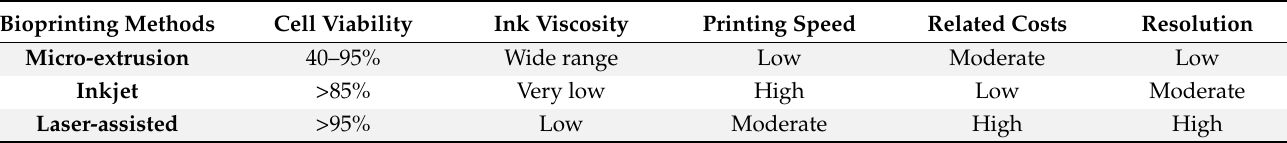
Figure 2. Schematic illustration for the process of 3D bioprinting. Reprinted with permission from ref. [20]. Table 1. Comparison of currently common 3D bioprinting